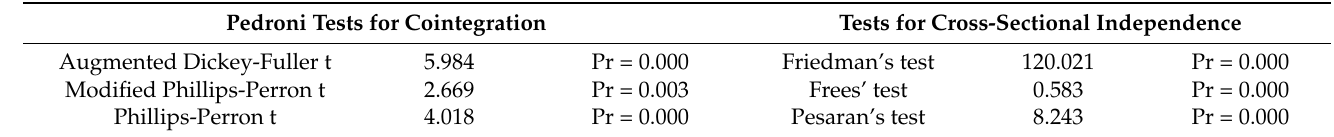
Table 2. Cointegration and Cross-Sectional Independence